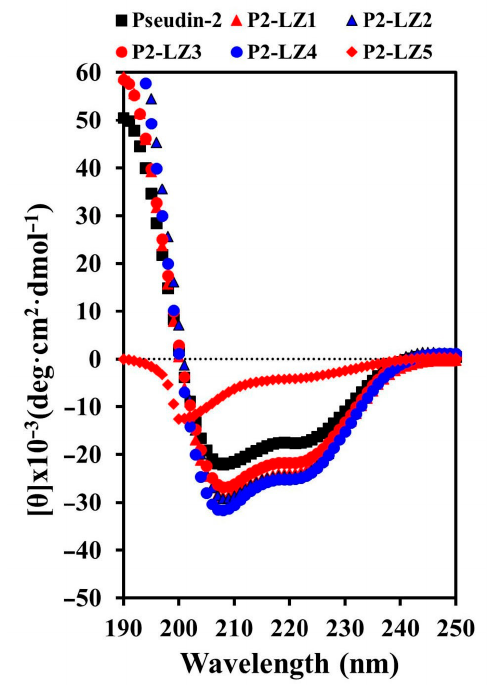
Figure 4. CD spectra of pseudin-2 and P2-LZ peptides. Far-UV CD spectra of peptides (30 µM) were obtained in PC / PE / PI / ergosterol (5:4:1:2, w / w / w / w ) liposomes.